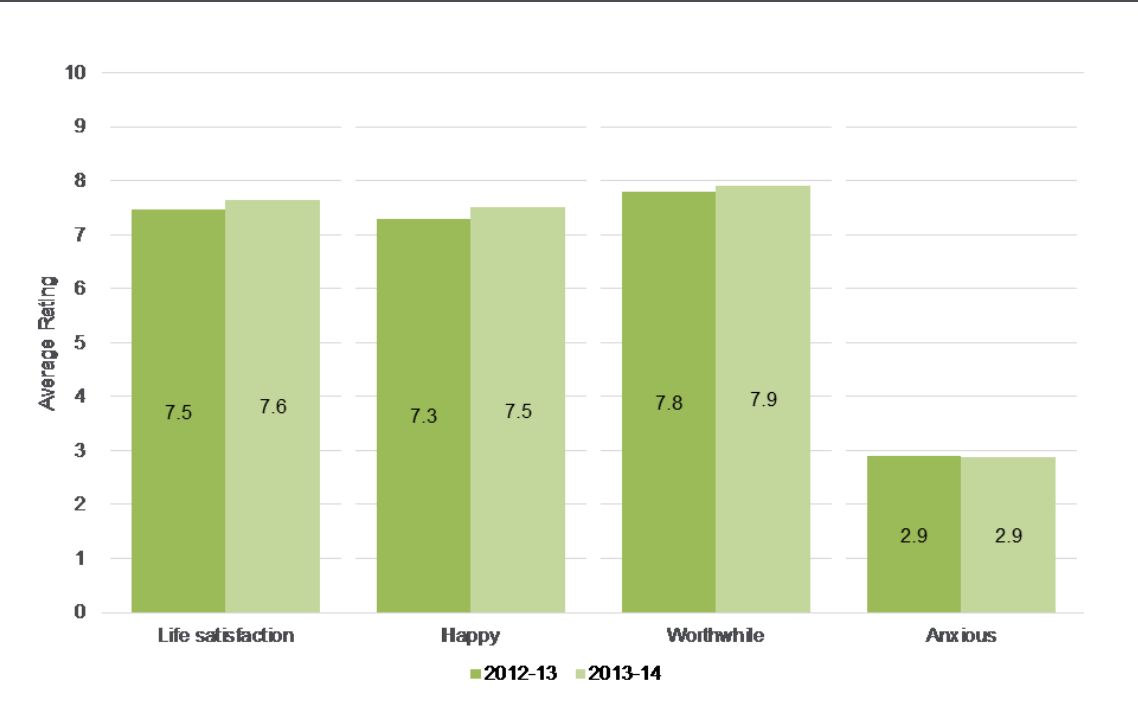
Figure 7: Average rating for well-being measures, 2012-13 to 2013-14